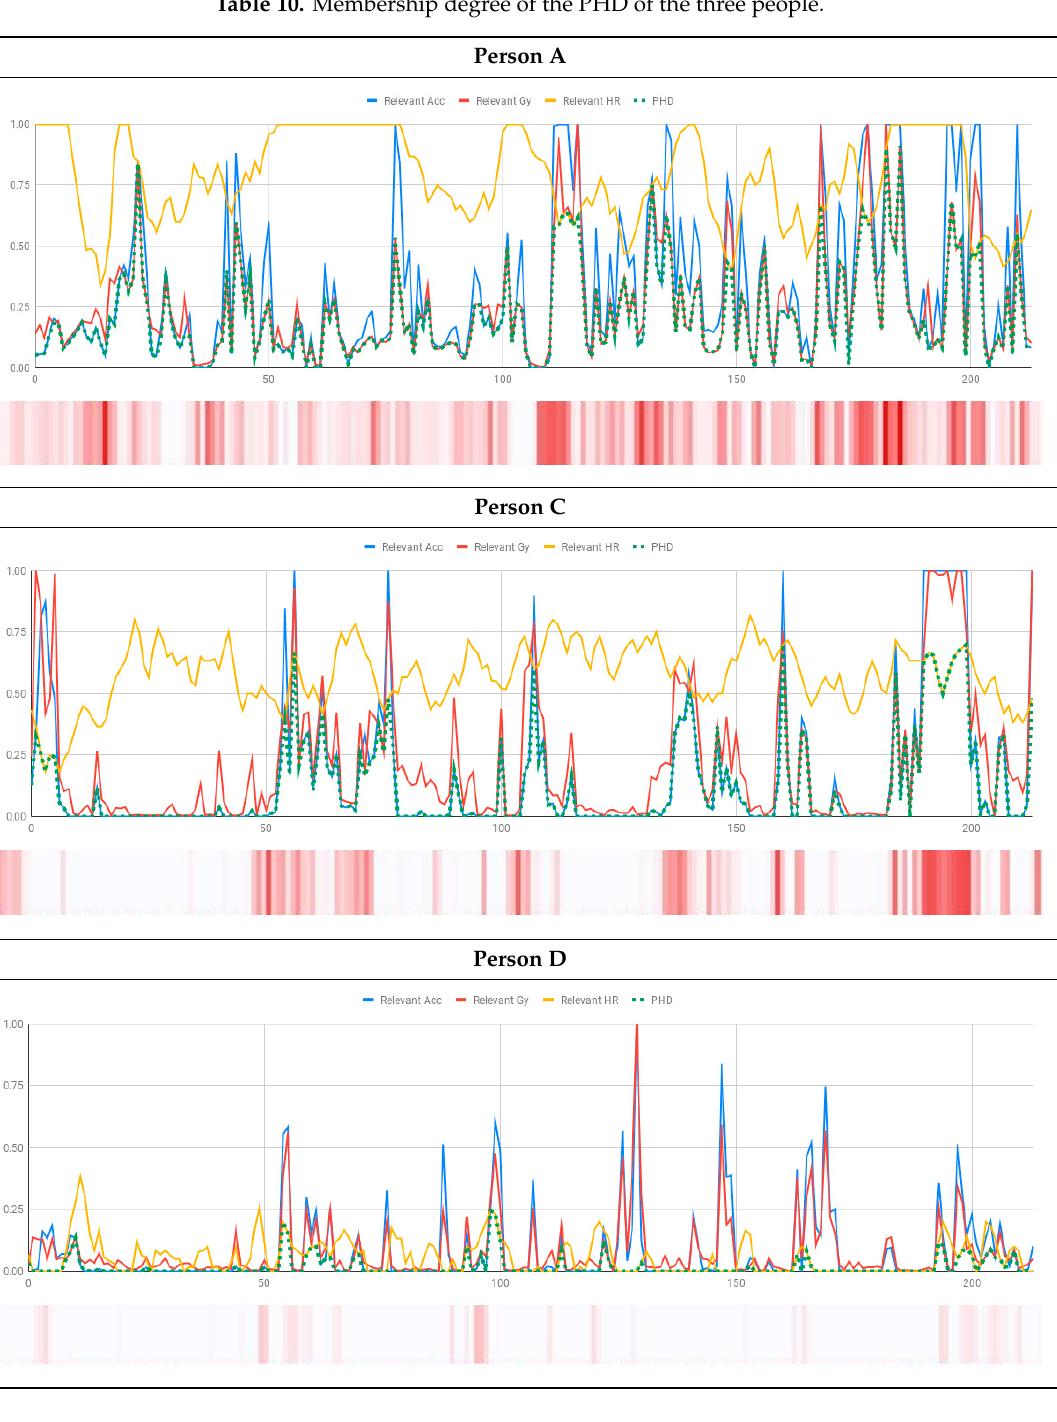
Table 10. Membership degree of the PHD of the three people.